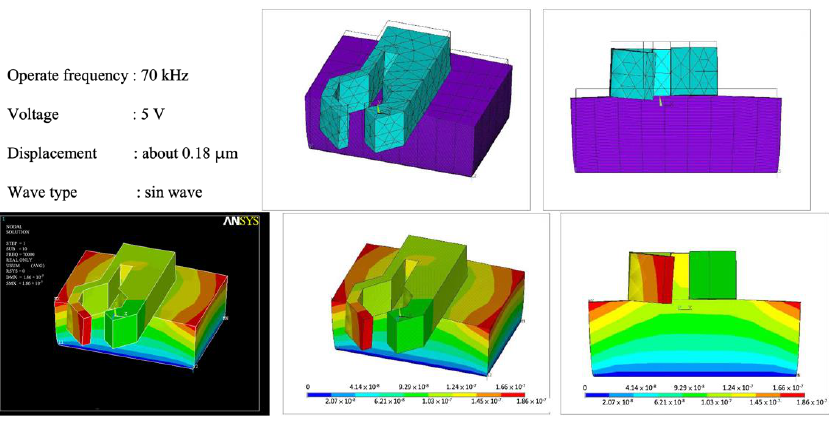
Figure 3. Lobster USM simulation result.